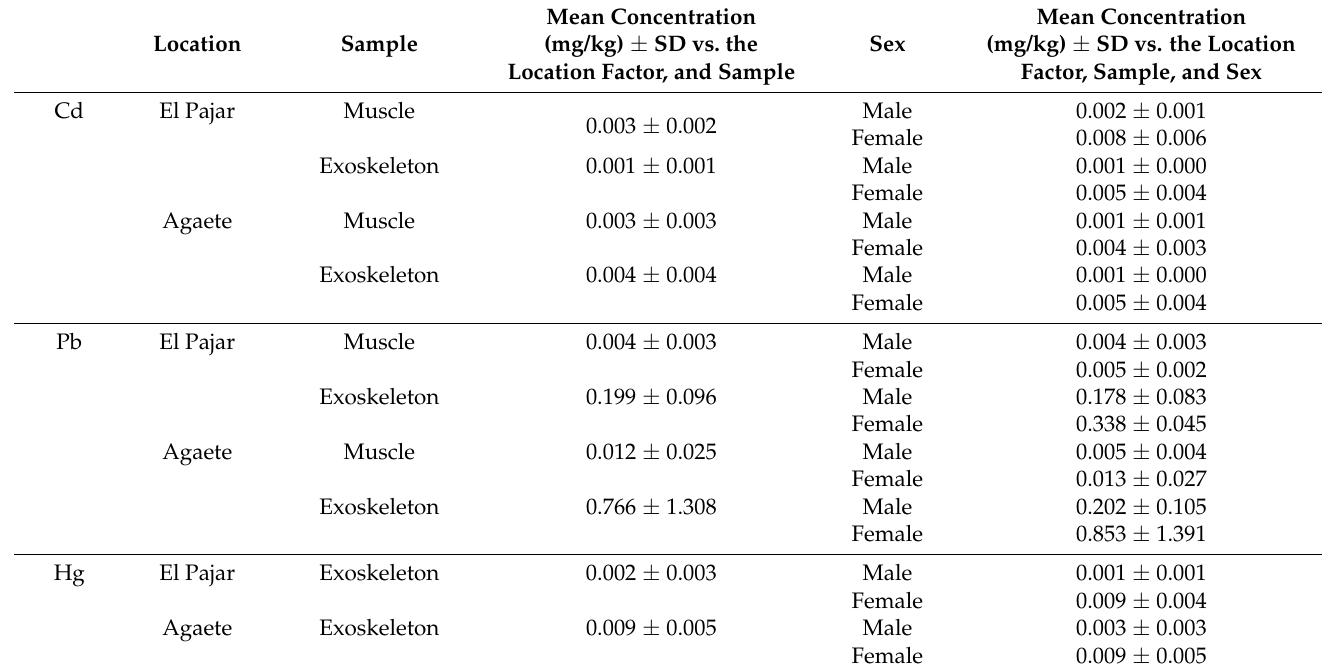
Table 2. Mean concentration and standard deviations in Cronius ruber (mg/kg), according to sex, location, and type of sample.